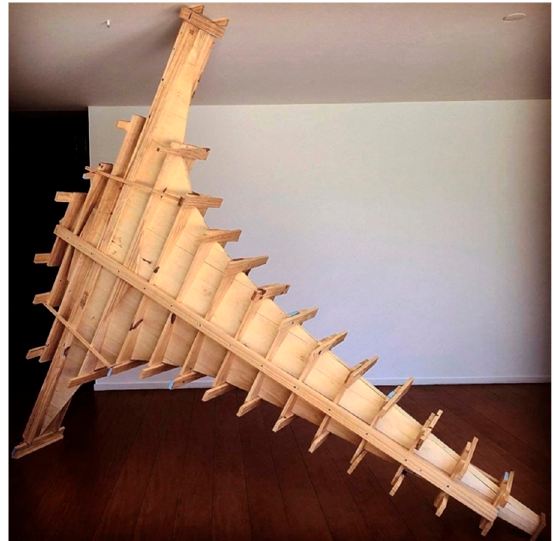
Figure 12. Lais Myrrha, Estudo para um Futuro Construído [Study for a Constructed Future], 2018, installation at Galeria Auroras.